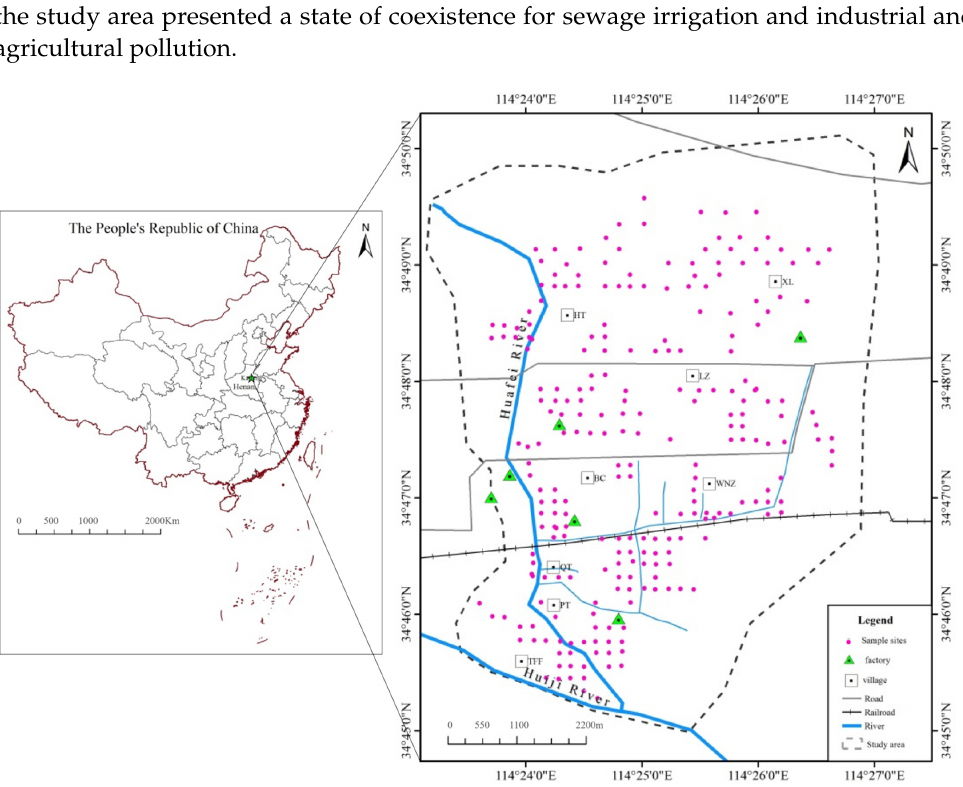
Figure 1. Location of study area and the sampling sites.